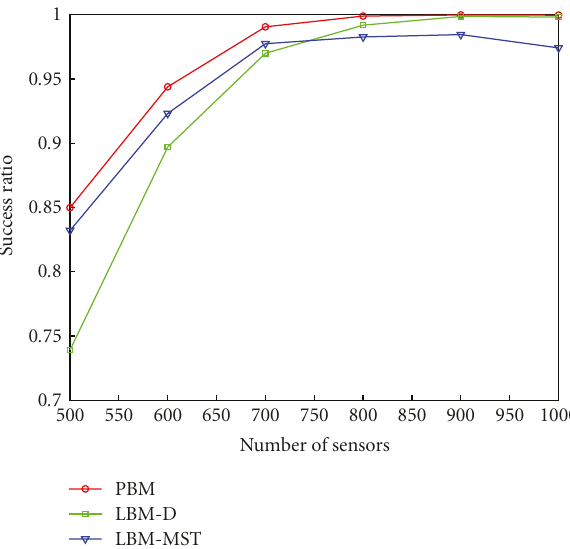
Figure 6: Success rates for randomly located destinations. Figure 7: Success rates for destinations grouped